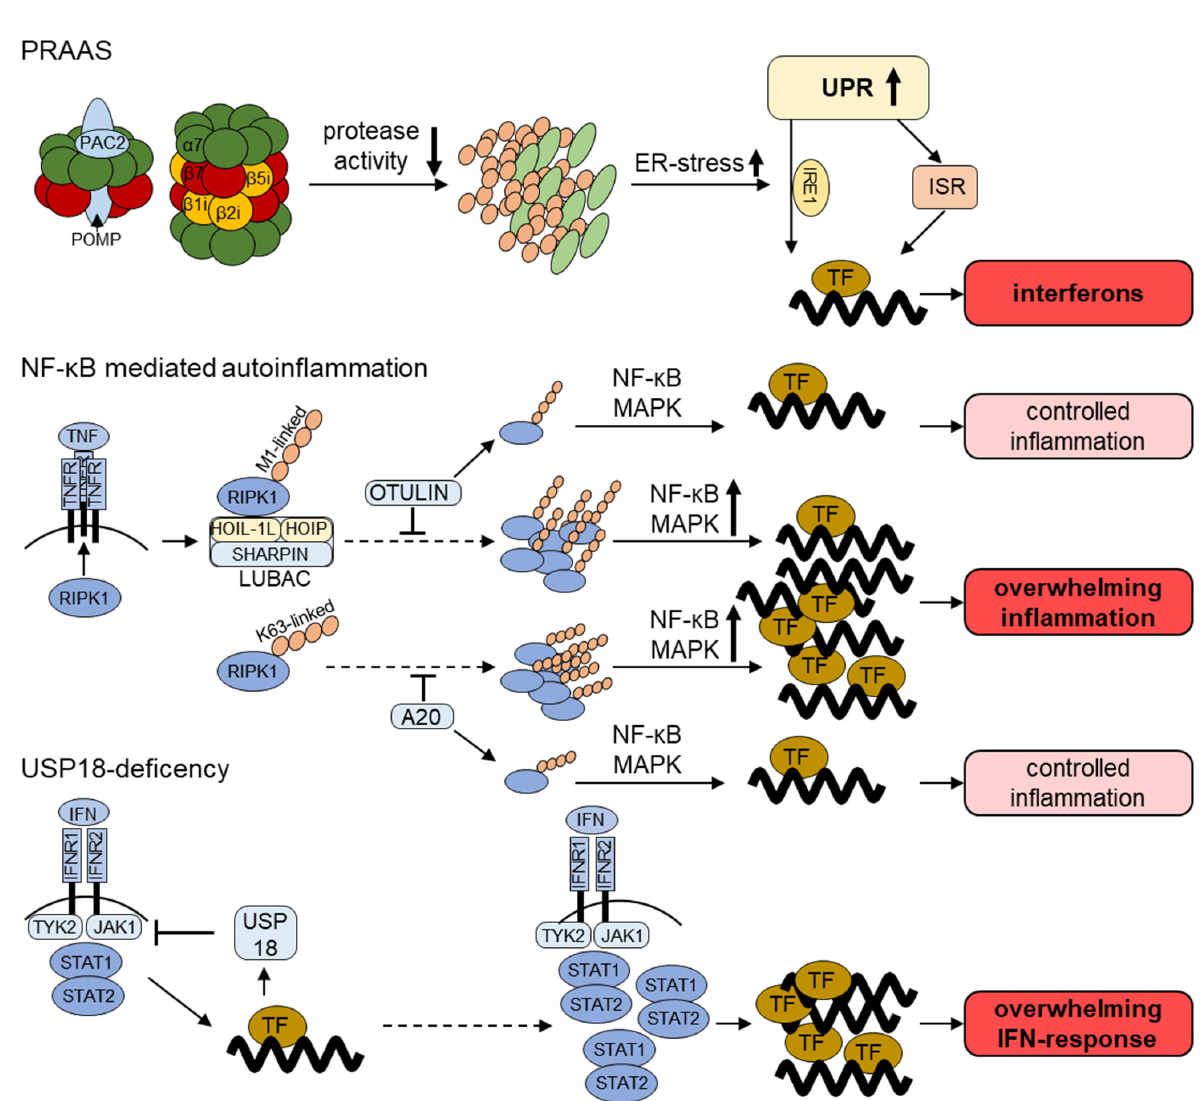
Figure 2. Current understanding of the pathogenesis of UPS dysfunction in autoinflammatory diseases. PRAAS (Proteasome-Associated Autoinflammatory Syndrome): proteasome loss-of-function mutations decrease proteasome proteolytic activity and result in intracellular accumulation of polyubiquitylated proteins. These proteotoxic aggregates induce ER-stress which initiates the unfolded protein response (UPR). The IRE1 (inositol-requiring enzyme 1) arm of the UPR has been shown to contribute to the transcription of IFN-stimulated genes (ISG). A possible involvement of the integrated stress response (ISR) in this process is also discussed. NF- κ B-mediated autoinflammation: PPR and cytokine receptor activation requires ubiquitylation for the induction of pro-inflammatory signaling. Depicted is the activation of the TNF receptor 1 (TNFR). The receptor-interacting protein kinase 1 (RIPK1) binds to the activated TFNR and is ubiquitylated with linear (M1-linked) poly-ubiquitin chains by the LUBAC complex or with K63-linked polyubiquitin. Polyubiquitylation is counterbalanced by the deubiquitinating enzymes (DUB) OTULIN and A20 in order to control the activation of the NF- κ B and MAPK pro-inflammatory pathways. USP18 deficiency: USP18 besides its DUB activity also directly regulates IFN signaling. It is upregulated following different pro-inflammatory stimuli and directly inhibits JAK1, thereby acting as a negative feedback loop. Disruption of this negative feedback leads to overwhelming inflammatory IFN